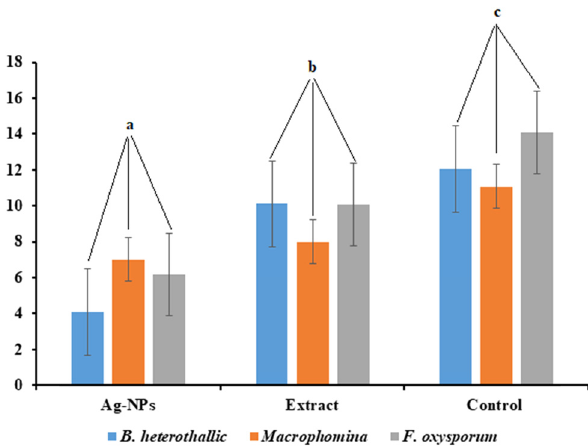
Figure 8: Antifungal activity of pure extract of A. vera ( a ) , Ag - NPs produced using A. vera ( b ) , and control ( c ) . Di ff erent letters show a signi fi cant di ff erence ( p ≥ 0.05 ) between the treatments and